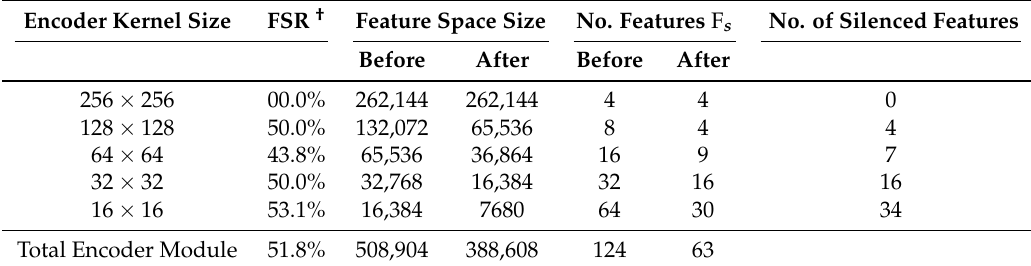
Total Encoder Module